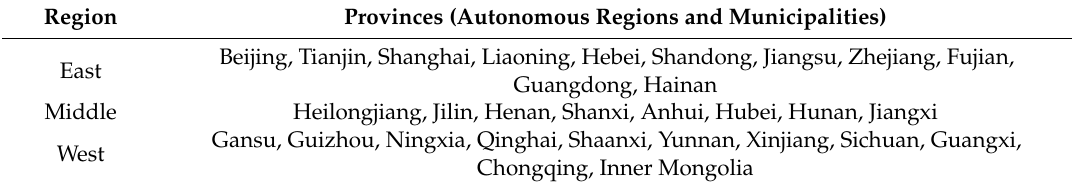
Table 1. Regional division of China. Region Provinces (Autonomous Regions and